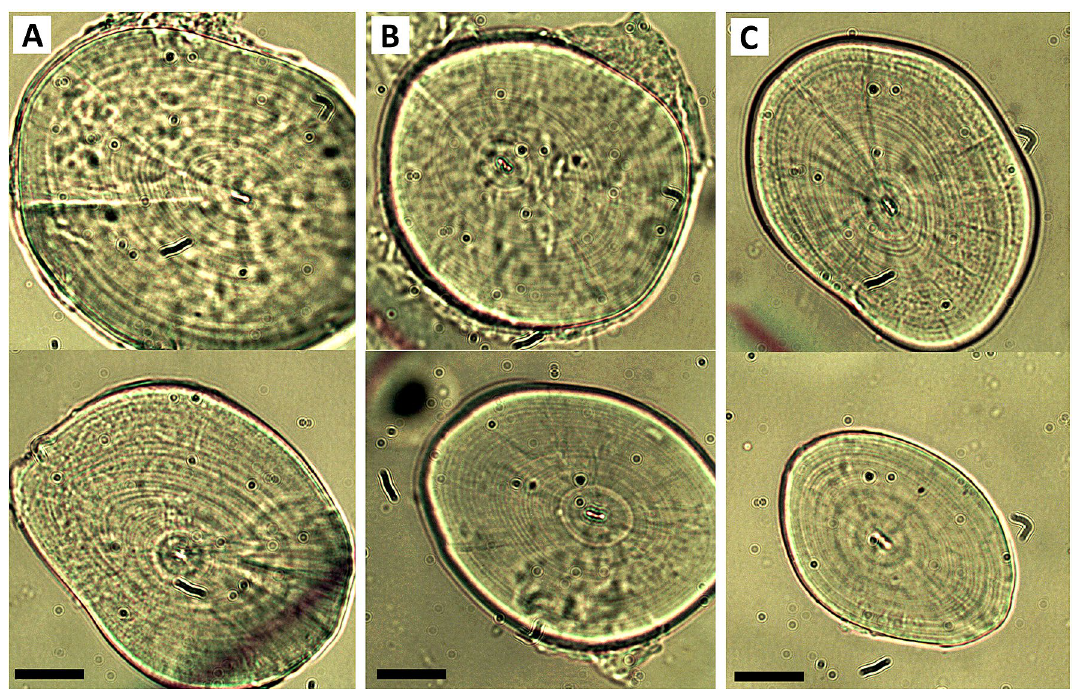
Figure 4. Sagittal otoliths from mature Schindleria specimens sampled with light traps from an inshore ( A ), a mid-shelf ( B ), and a shelf-edge ( C ) reef in the Red Sea, near the coast of Thuwal, Saudi Arabia. These otoliths represent otoliths of ideal conditions (i.e., “C3” category) to count daily growth increments and yielded similar average numbers of increments (between 26 and 28) despite slightly differing shapes and sizes. All otoliths are to scale, with the bar at the bottom (left) of each panel representing 20 μm. The otolith at the top of each panel represents a rounder and larger otolith while the otolith at the bottom a more oval-shaped and smaller